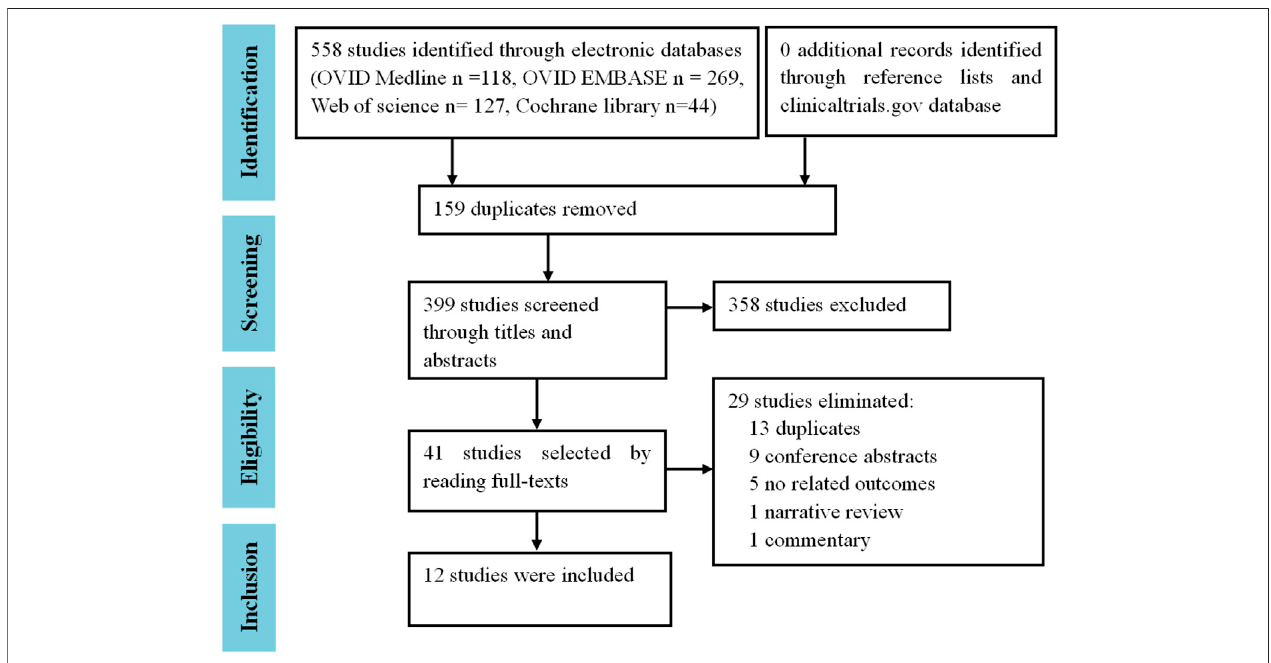
FIGURE 1 | Study selection flow